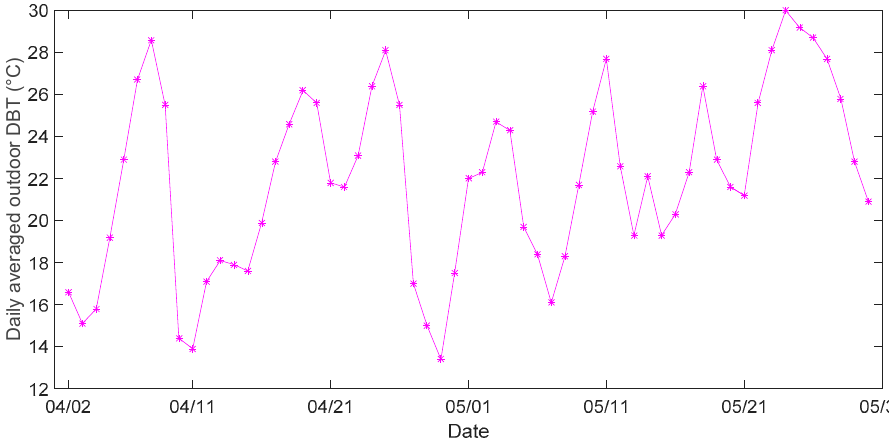
Figure 4. Daily averaged outdoor DBT values during the experiment.